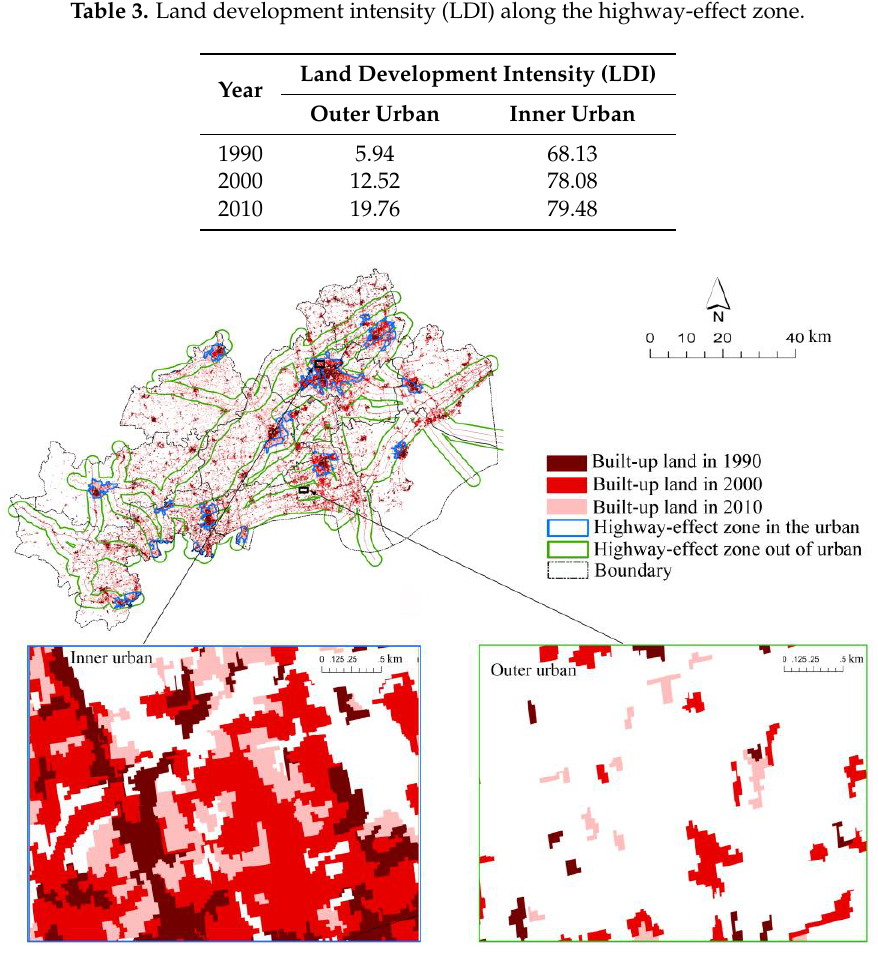
Table 3. Land development intensity (LDI) along the highway-effect zone.